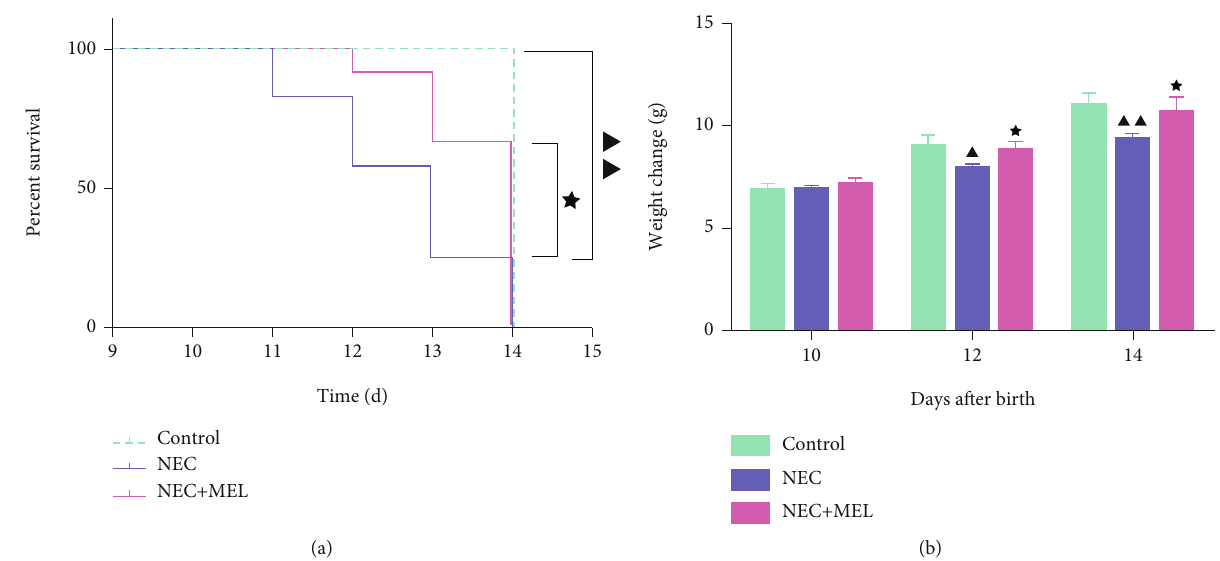
Figure 1: MEL intensi fi ed the survival rate and body weight in NEC mice. (a) MEL enhanced the survival rate in NEC mice. (b) MEL elevated body weight in NEC mice. ▲ P < 0 : 05 , ▲▲ P < 0 : 01 vs. control; ★ P < 0 : 05 vs. NEC. NEC: necrotizing enterocolitis; MEL: